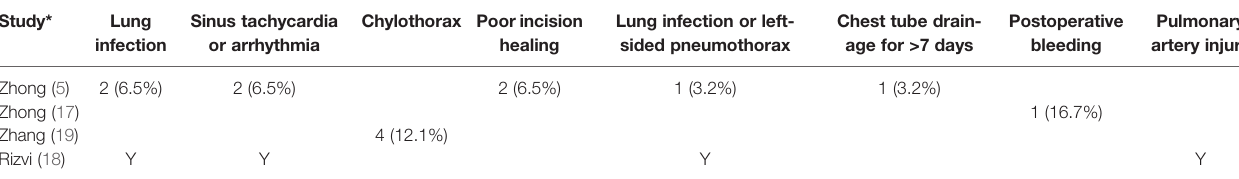
TABLE 4 | Postoperative complications.